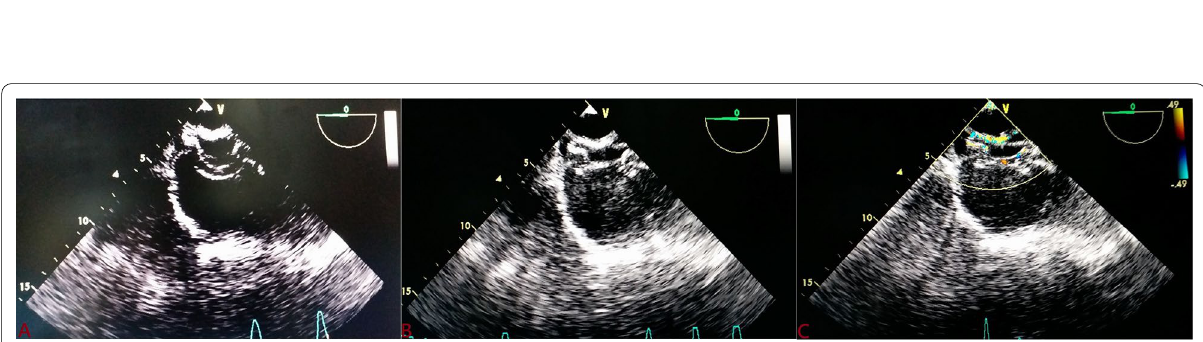
Fig. 8 Device deployment using BAT technique. ( A Waist and right disk are quickly deployed after retracting the sheath into RA; B properly opened disks; C Minnesota maneuver was performed to check the stability of the device)